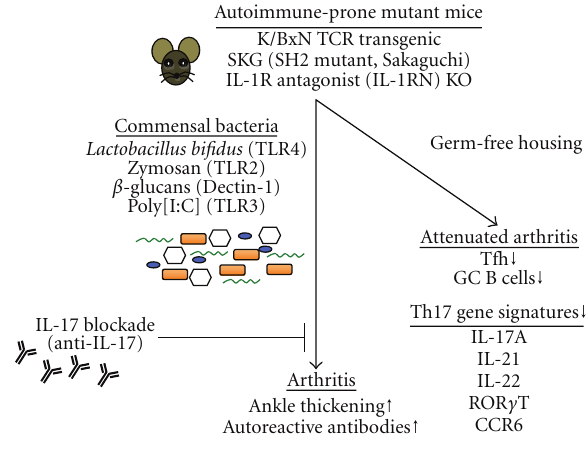
Figure 2: Linking Th17 cells and IL-17 to infection and autoimmunity. Table 2: Clinical aspect of therapies targeting the IL-17